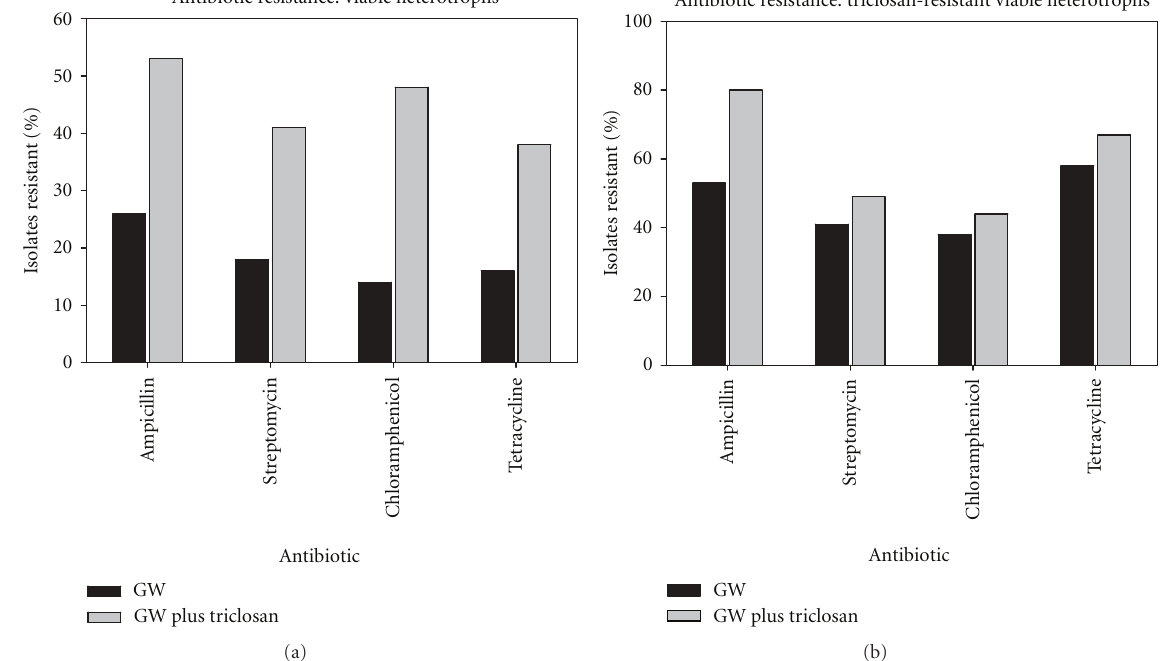
Figure 2: Proportion of isolates resistant to selected antibiotics. Individual isolates of selected populations of microorganisms were screened for resistance to antibiotics. Values reported are the mean of all isolates after 10 weeks irrigation.